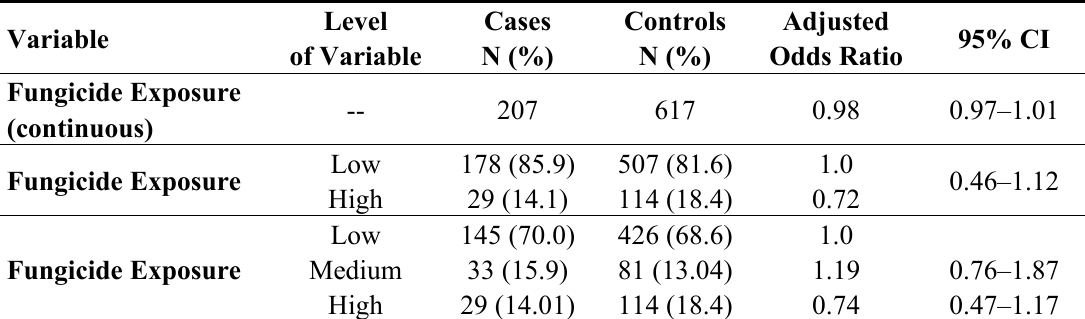
Table 2. Unconditional multivariable logistic regression models a of association between breast cancer risk and fungicide exposure, PEI, 1999–2003.